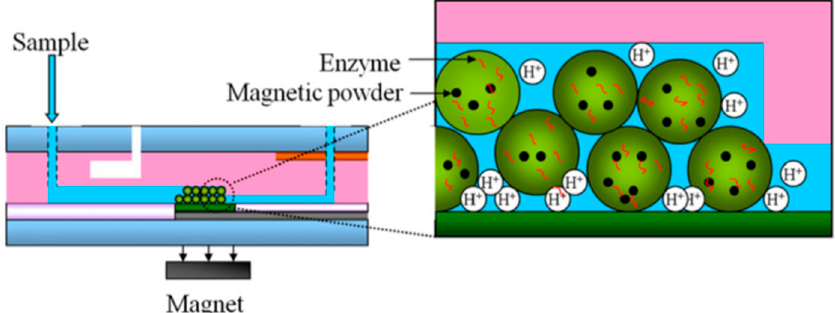
Figure 3. Operating principle of a microfluidic chip. Enzyme-carrying alginate microbeads are immobilized on the EIS-sensor surface by means of an external magnetic field. The sample is injected into the microchannel and reacts with the enzyme contained in alginate beads. The change in potential on the sensor surface induced by the release of hydrogen ions during the reaction process is measured. Reproduced from Ref. [82] with permission of Elsevier.